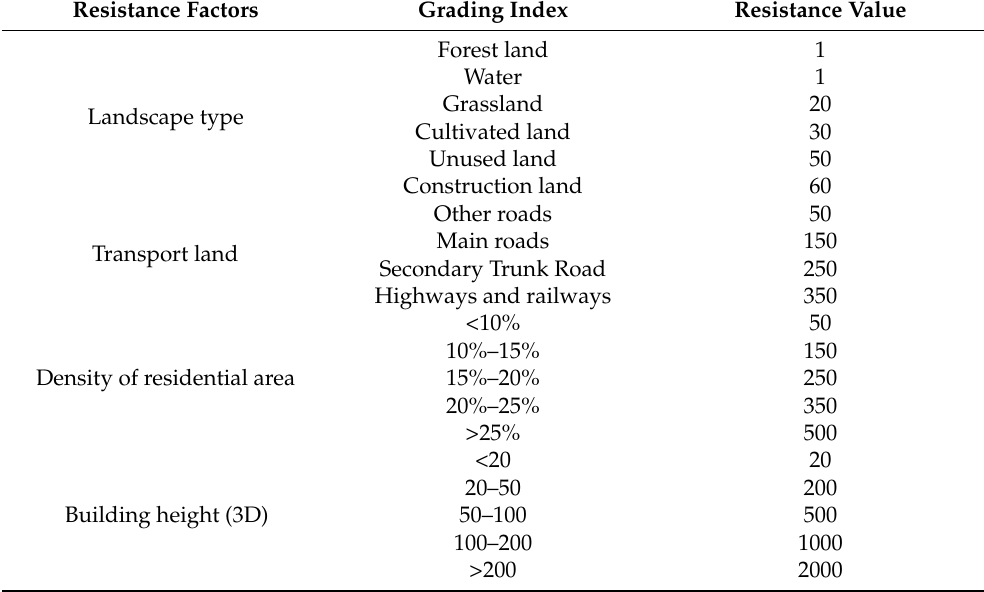
Table 4. Resistance factor types and